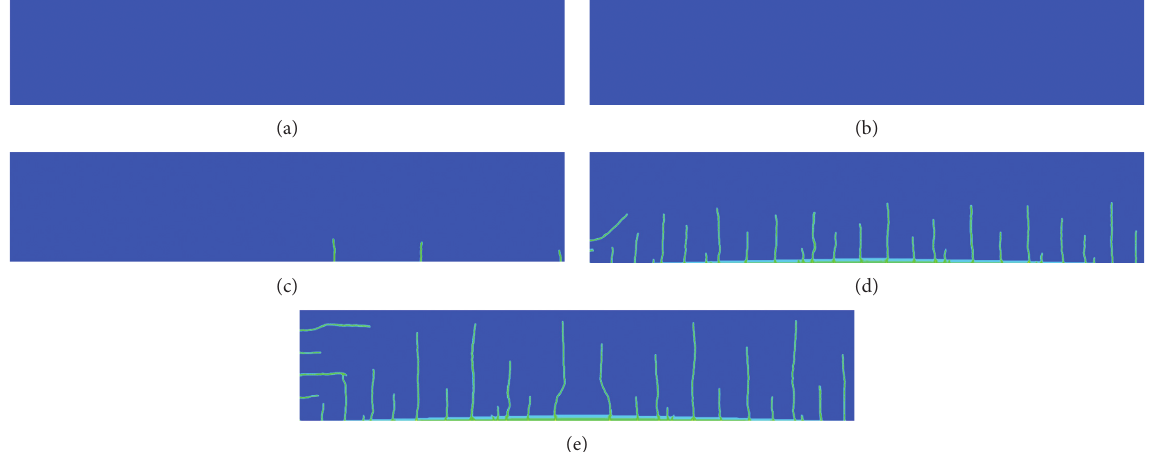
Figure 14: Thermal crack paths with different material shapes ( t � 1.0 s): (a) M